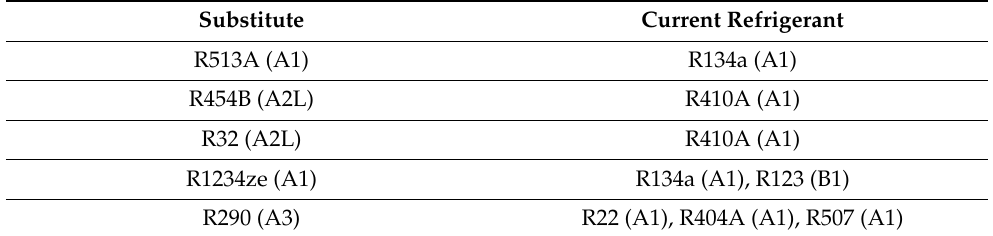
Table 2. Substitutes for selected refrigerants commonly used in air-conditioning systems and in compressor refrigeration devices with their safety classes [38,39].